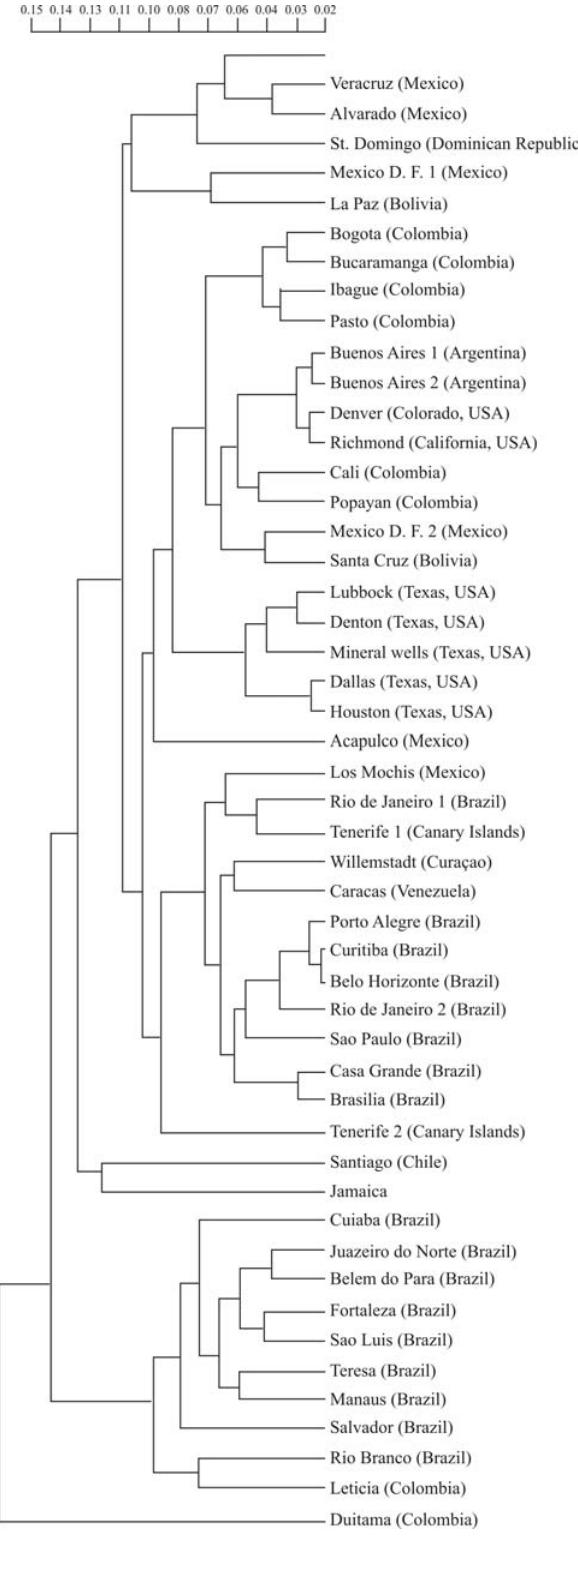
Figure 3 - Phenetic analysis of 50 Latin American and U.S. Southwest cat populations, estimated by using the UPGMA algorithm with the Prevosti genetic